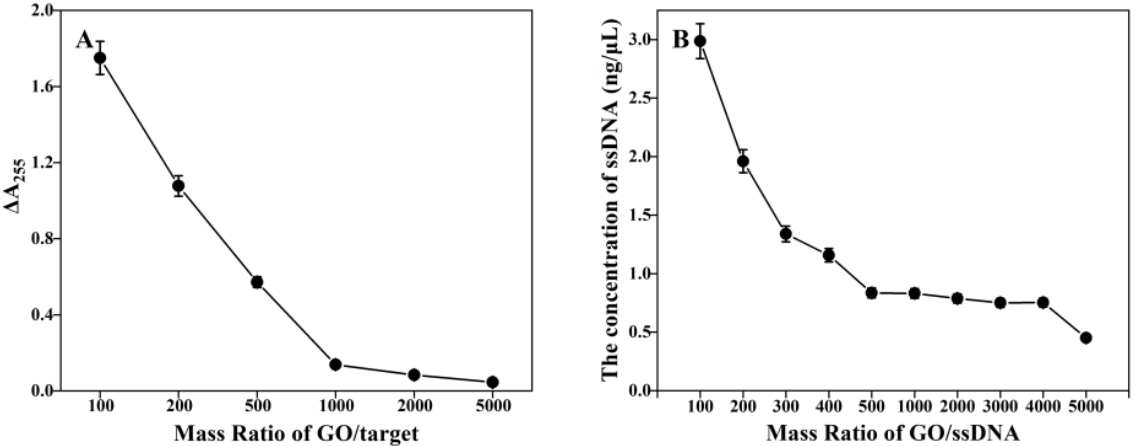
Figure 2. ( A ) Optimization of the mass ratio of GO and target. Δ A255 indicated the difference value between the absorbance value at 255nm of the supernatant (GO/target) and the control (GO/1 × Binding buffer). ( B ) Optimization of the mass ratio of GO and ssDNA. The concentration of ssDNA indicated the content of free ssDNA in the supernatant.